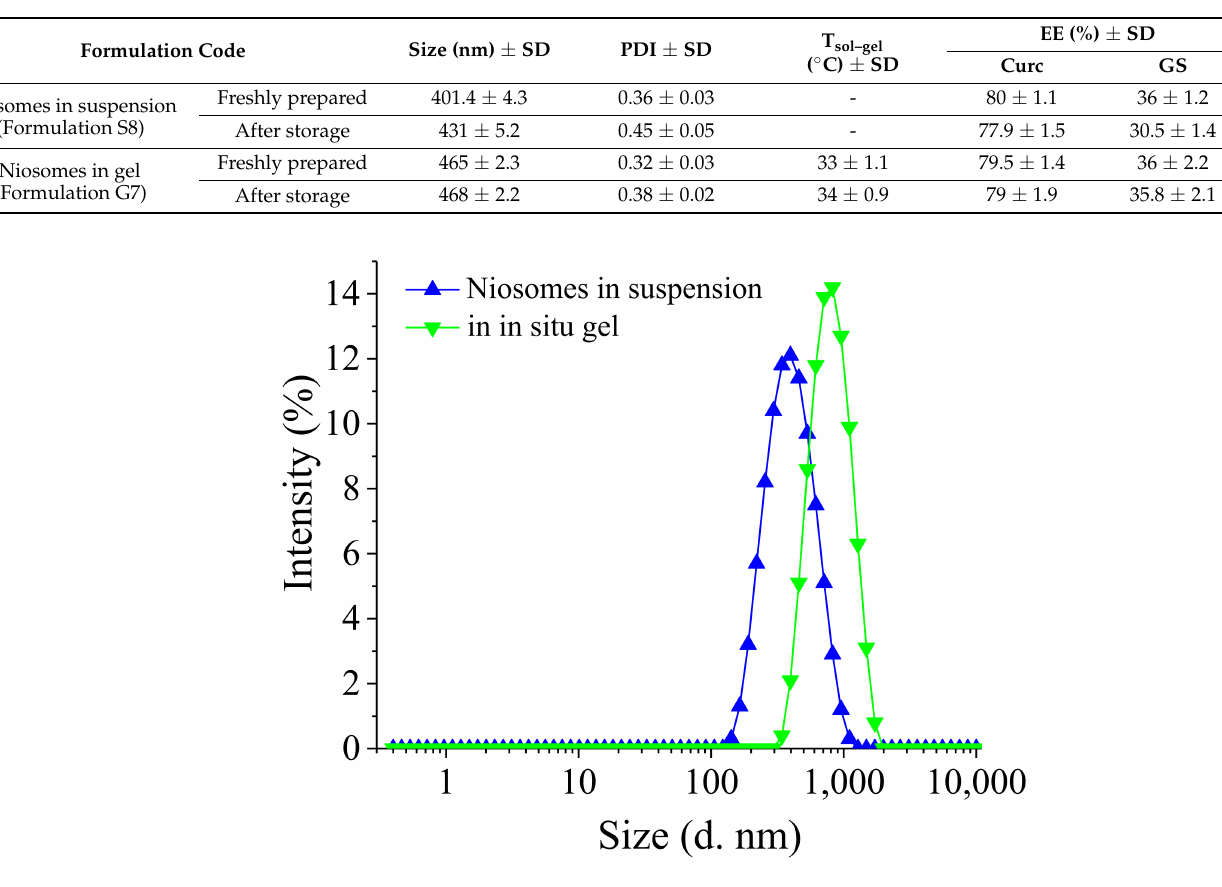
Figure 8. Size distribution of Curc/GS simultaneously loaded Tw60:Sp60:Chol (3.5:3.5:3 mol:mol) niosomes in suspension and after their formulation in in situ gel. DLS measurements of in situ gel were made after sufficient dilution with distilled